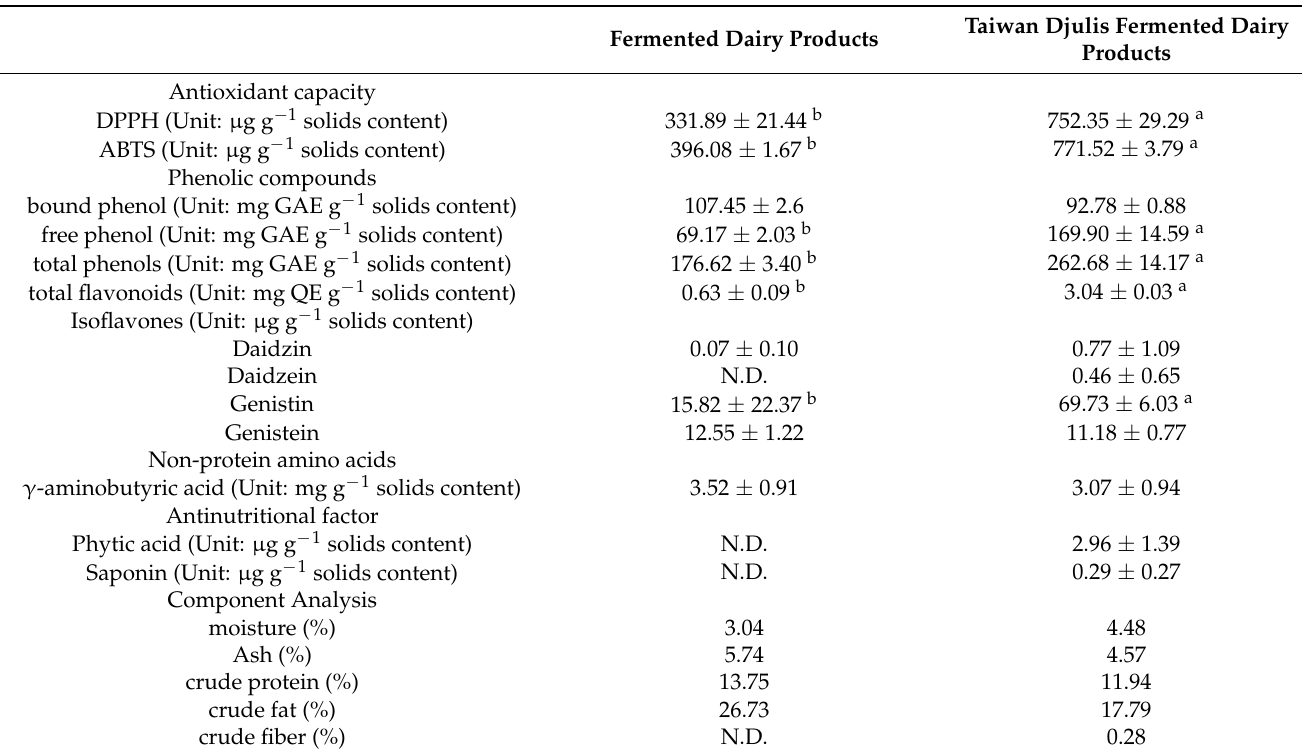
Table 1. Comparison of antioxidant capacity, phenolic compounds, isoflavones, GABA and anti- nutritional compounds in fermented dairy products and Taiwan djulis fermented dairy